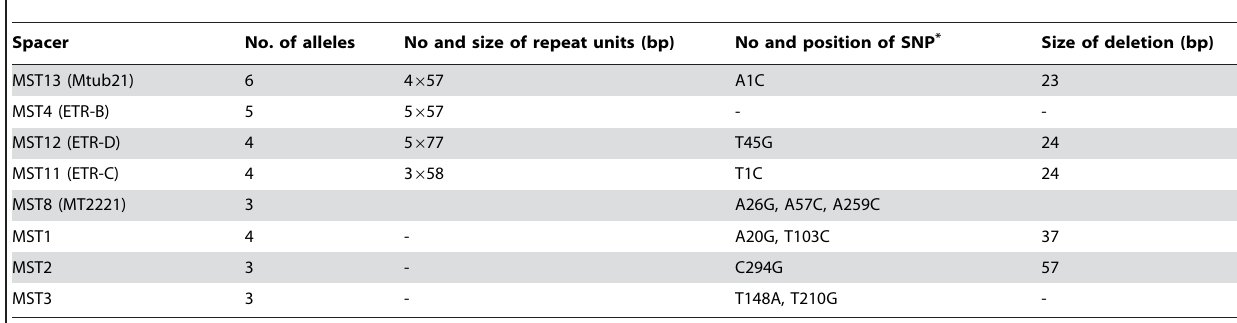
Table 2. Polymorphism characteristics of 8 variable intergenic spacers studied in M. tuberculosis isolates.